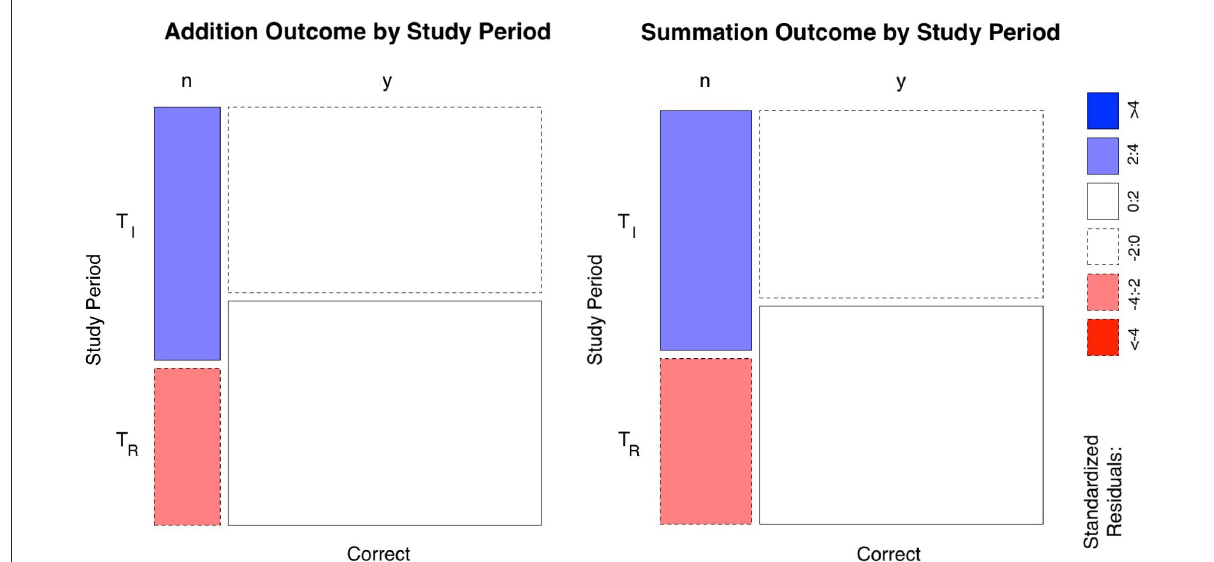
FIGURE1 Mosaic plots of the mental arithmetic learning task outcomes subsetted by study phase. The width of the columns indicates the proportions in each group, which corresponds to the column totals in Table 2. The height of the boxes (rows/horizontal break) is the proportions of the outcomes in each of the initial (T I ) and return (T R ) study periods, which represents the rows of Table 2. Standardized residuals indicate that there are more (blue) observations than would be expected under the null model for erroneous responses in the T I period and less (red) in the T R period for both tasks. Since the horizontal bars are at unequal levels, therefore there is a statistically significant difference between task outcome and study period. i.e. there was a statistically significant difference between correct responses and errors in both the T I and T R study periods. y=yes, n =